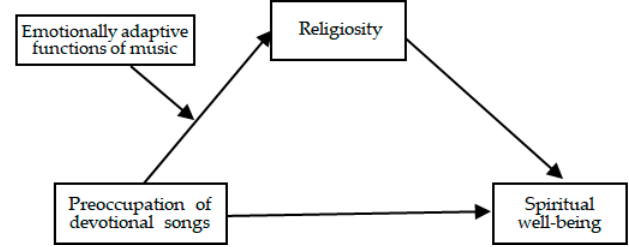
Figure 1. Moderated mediation model of the study.